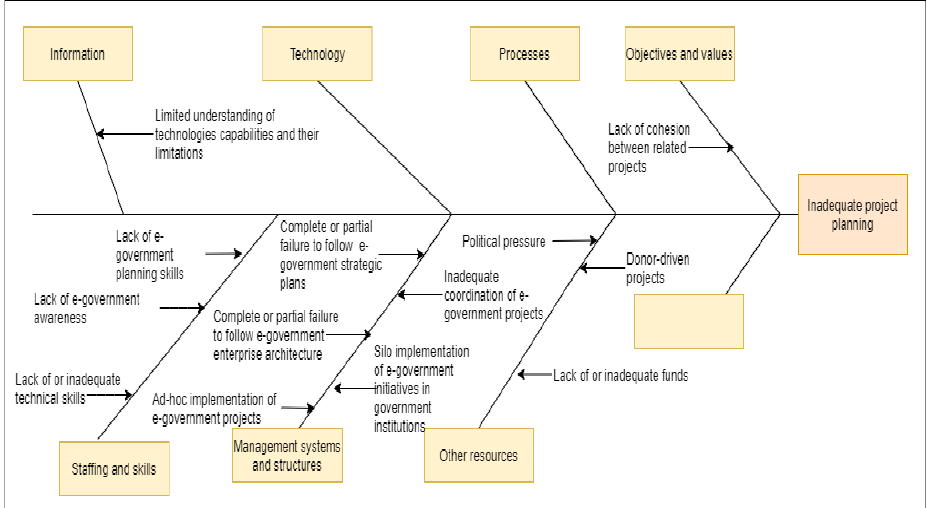
Figure 5: Inadequate project